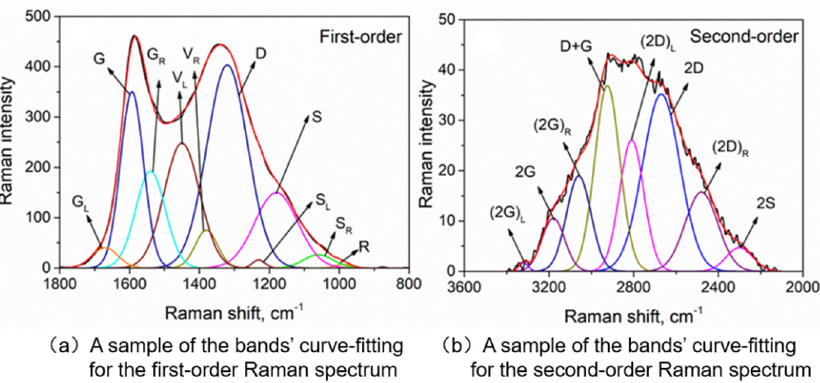
Figure 1. A sample of the bands’ curve-fitting. Table 1. A summary of the bands’ assignment [2,4–6,9,20,22,23,25–28].